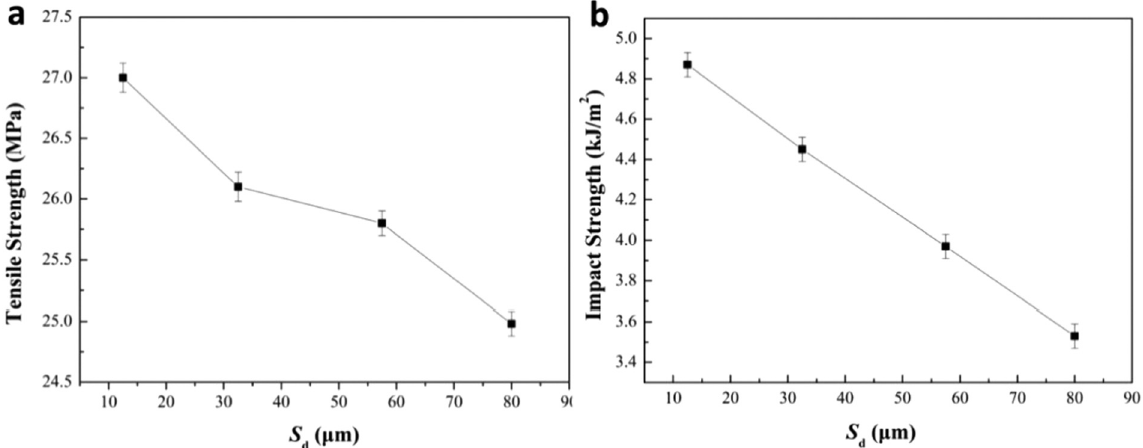
Figure 4: Relationships of the cell size distribution and ( a ) the tensile and ( b ) impact strengths of the PP foams with the same volume expansion ratio.